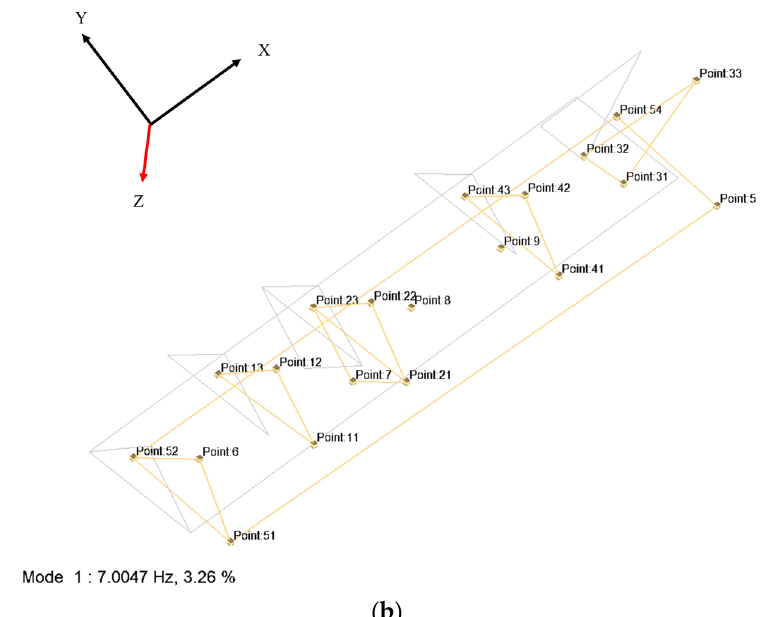
Figure 8. Impact excitation ( a ) location and direction, ( b ) The lateral mode shape at 7.0 Hz was identified by impact testing for the standstill rotor.